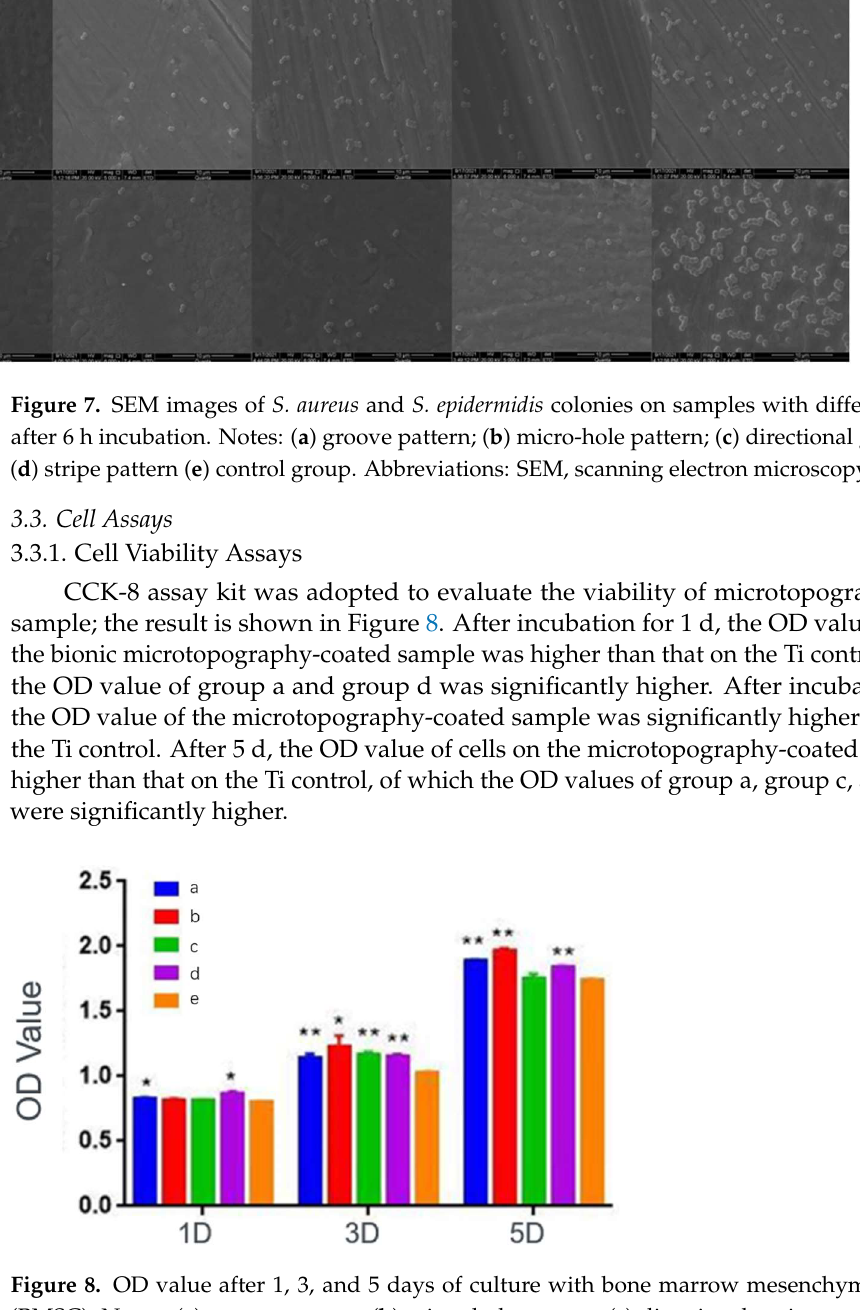
9 of 14 Figure 6. CLSM images of S. aureus and S. epidermidis colonies on samples with different coatings after 6 h incubation. Notes: ( a ) groove pattern; ( b ) micro-hole pattern; ( c ) directional grain pattern; ( d ) stripe pattern ( e ) control group. Abbreviations: CLSM, confocal laser scanning microscopy. 3.2.3. Scanning Electron Microscopy (SEM) Assays SEM was also used to examine bacteria attachment on the sample surfaces (Figure 7).